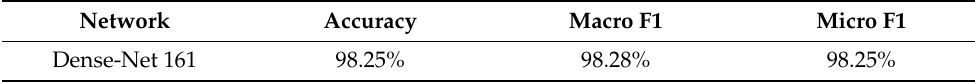
Table 13. The evaluation results of the second experiment on the PETA dataset.